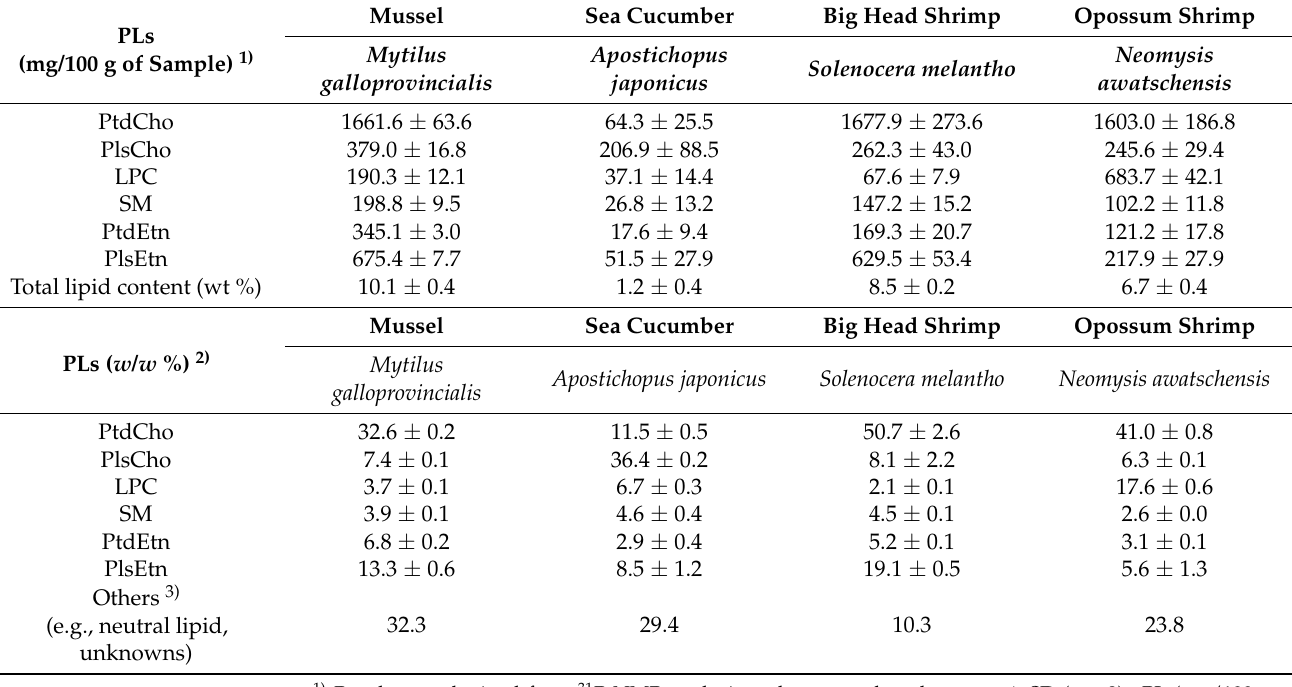
Table 2. Total lipid content (wt %) and quantitative value (mg/100 g) and composition ( w / w %) of phospholipids extracted from the dried big head shrimp, opossum shrimp, mussel, and sea cucumber determined using 31